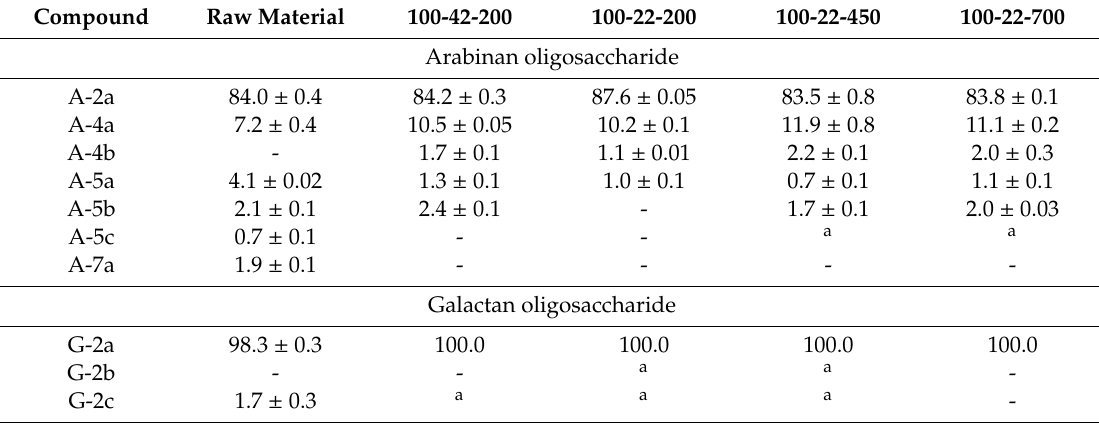
Table 5. Arabinan and galactan oligosaccharide composition (mol%) after incubation of insoluble dietary fiber of raw and extruded apple pomace with endo -arabinanase and endo -galactanase (mean value ± range / 2, n =